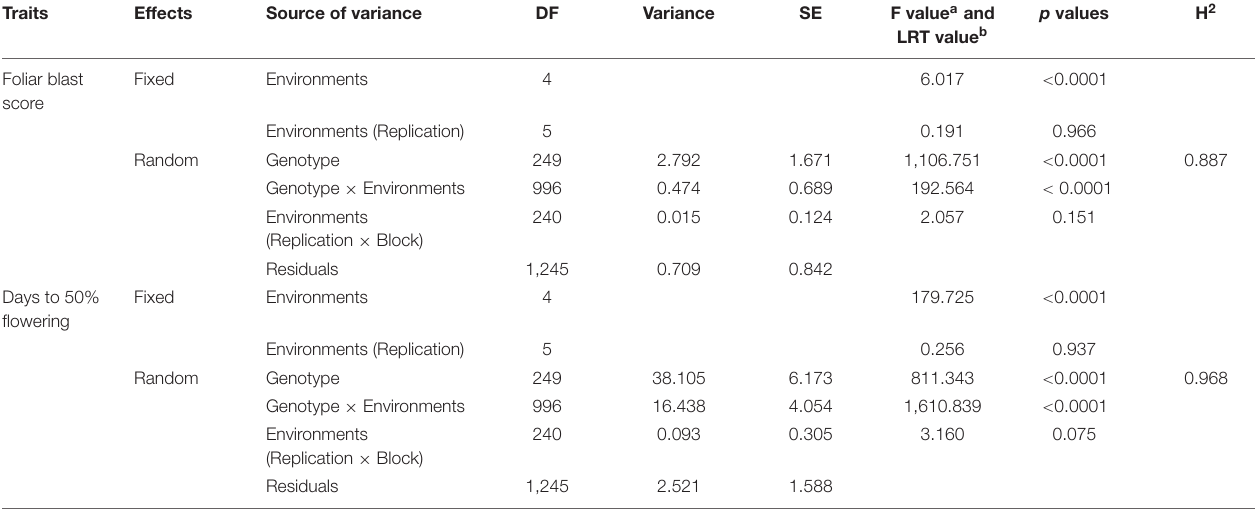
TABLE 4 | Combined analysis of variance for foliar blast resistance and days to 50% flowering in pearl millet. Traits